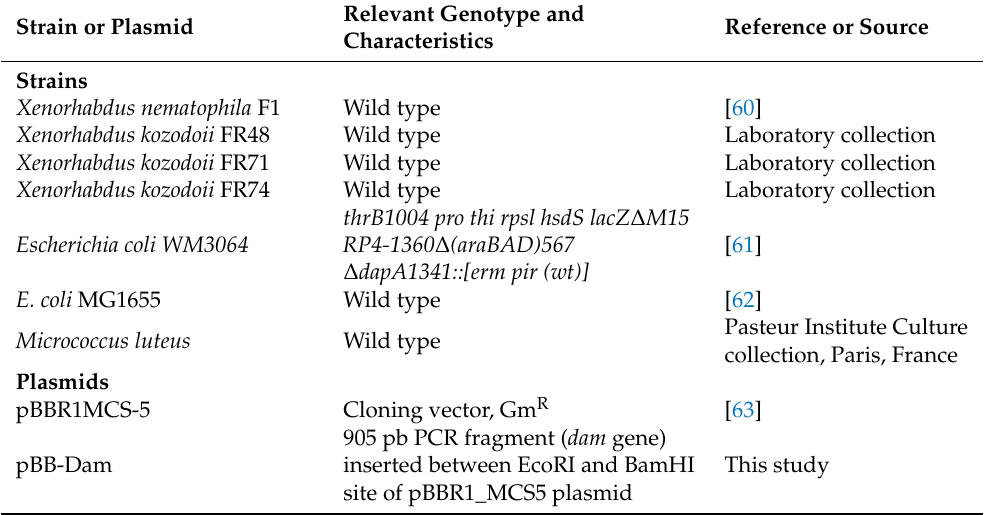
Table 3. Strains and plasmids used in this